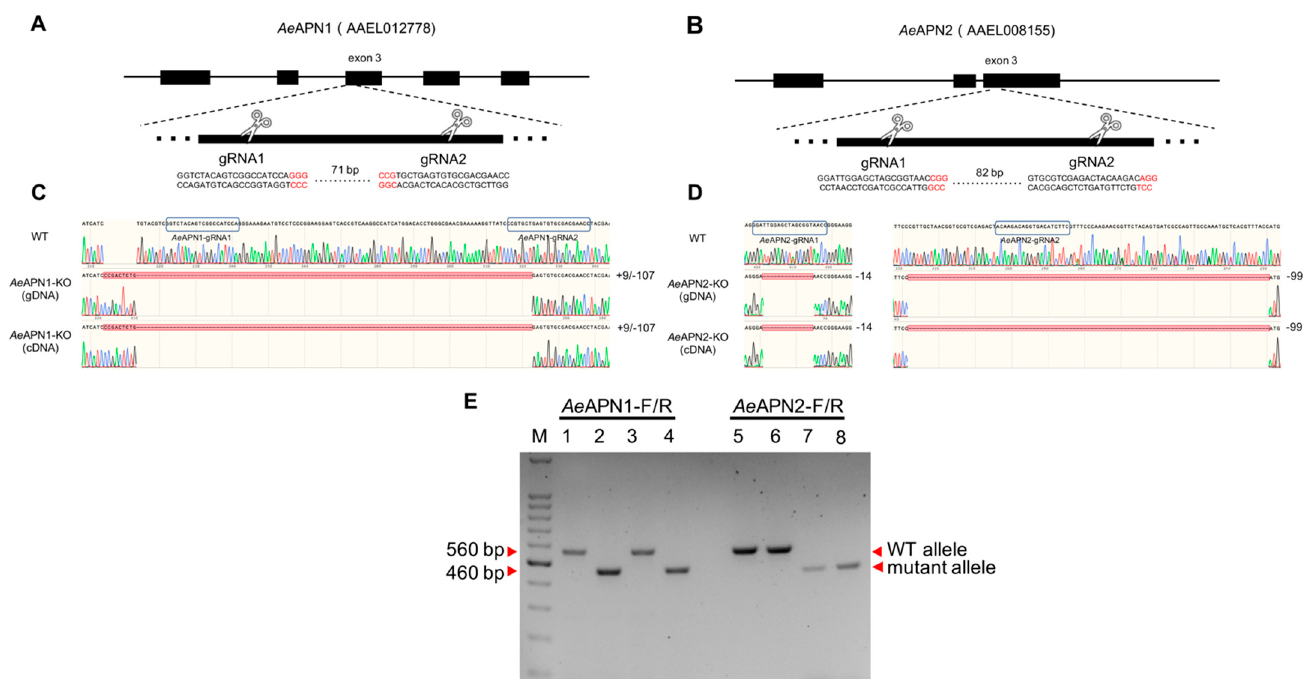
Figure 1. Generation of Ae APN knockout Ae. aegypti strains. Schematic representations of the Ae APN1 ( A ) and Ae APN2 ( B ) locus, where enlarged is the third exon contain 20-nucleotide sgRNA target sequences, and the PAM sequence shown in red. Aligned Sanger-sequencing trace of PCR-amplified using gDNA and cDNA from WT, AeAPN1-KO and AeAPN2-KO strains with specific primers (Table 1) spanning the gRNA targeted region ( C , D ). Electrophoresis of genomic-PCR products spanning target region from WT, Ae APN1-KO, AeAPN2-KO, and AeAPN1/AeAPN2-KO strains with specific primers Ae APN1-F/R and Ae APN2-F/R ( E ), Lane M: 100 bp DNA Ladder (TaKaRa, Dalian, China), Lane 1 and 5: the fragments were amplified from gDNA of the WT strain, Lane 2 and 6: the fragments were amplified from gDNA of the AeAPN1-KO strain, Lane 3 and 7: the fragments were amplified from gDNA of the AeAPN2-KO strain, Lane 4 and 8: the fragments were amplified from gDNA of the AeAPN1/AeAPN2-KO strain.